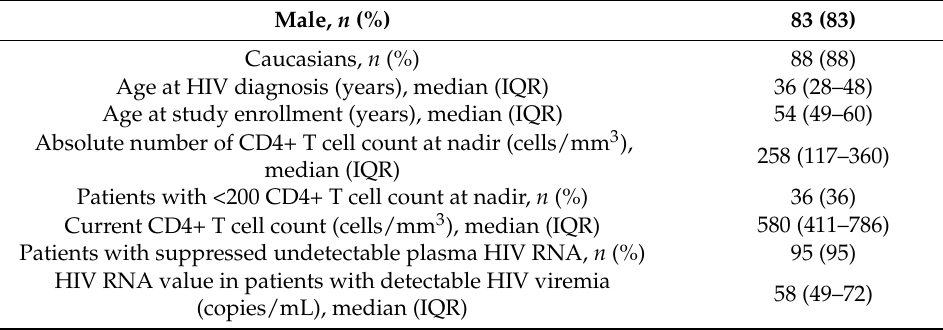
Table 1. Main characteristics of the study population ( n =